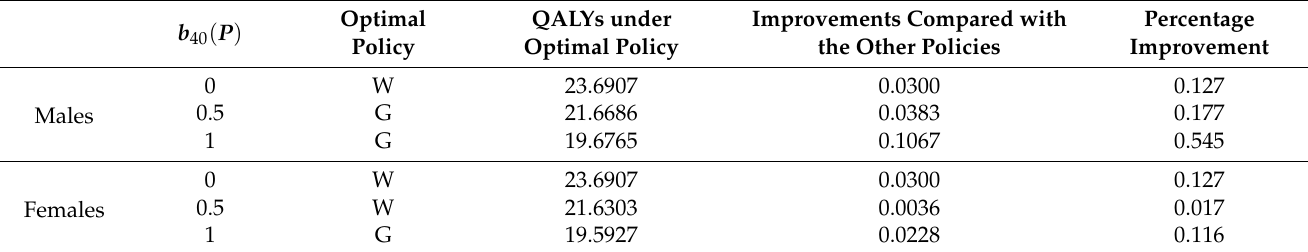
Table 4. Comparison of QALYs between the optimal policy to other